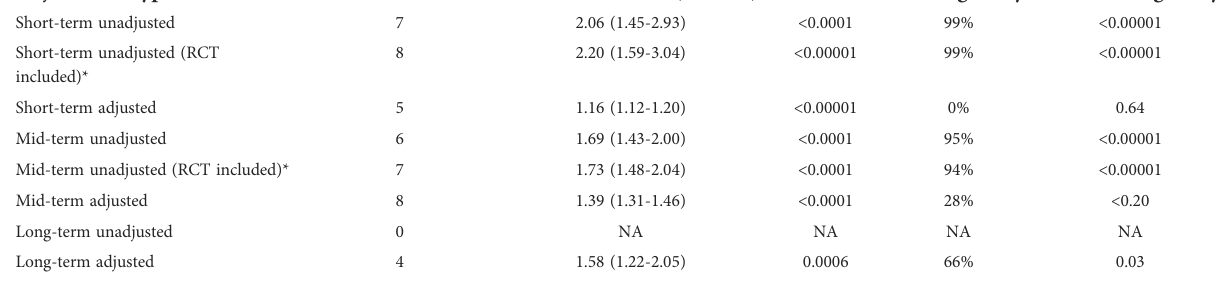
TABLE 2 Pooled sex-speci fi c risk ratio (RR) for post-AMI all-cause mortality associated with diabetes. 2a. Pooled RRs for Men with Diabetes Compared with Men without Diabetes. Adjustment